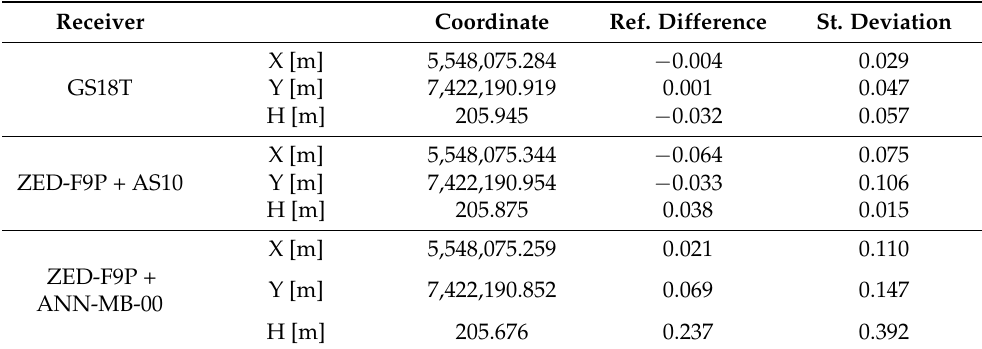
Table 8. Measurement results on Pt